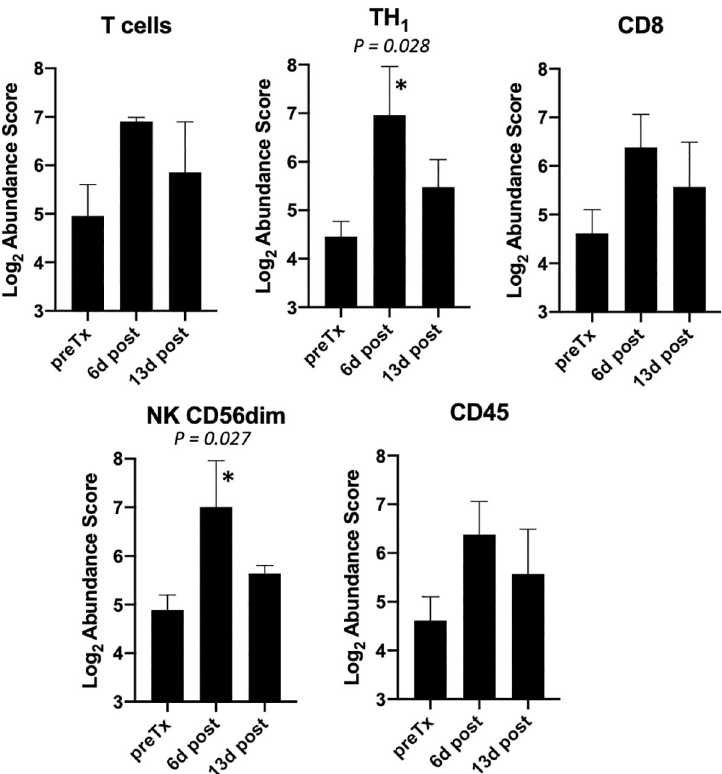
Fig 7. Primary tumor cell type profiling before and after therapy initiation. The cell abundance scores (Mean +/- SEM) for all dogs (n = 3) primary tumors in the experiment are displayed and grouped by cell type. Cell Type Scores are based on the NanoString Cell Type Profiling Module. P values are for non-parametric repeated measures ANOVA (Friedman test) and ‘ � ’ identifies those time points deemed significantly different ( P < 0 . 05 ) from pretreatment baseline by Dunn’s multiple comparison